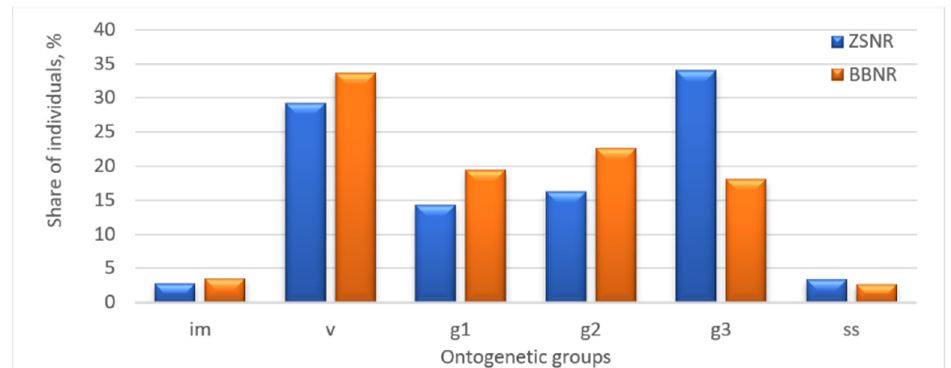
Figure 1. Age structure of P. chlorantha populations in the Zhiguli State Nature Reserve (ZSNR) and in the Buzuluksky Bor National Park (BBNR): im—immature; v—virginal; g1—young generative; g2—mature generative; g3—old generative; ss—sub-senile individuals (compiled by the authors). The dynamics of the age structure of P. chlorantha populations were worth analyzing separately in the Zhiguli State Nature Reserve and in the Buzuluksky Bor National Park (Figures 2 and 3). In order to estimate the composition and dynamics of populations, we chose the data for the years with the highest number of recorded individuals.